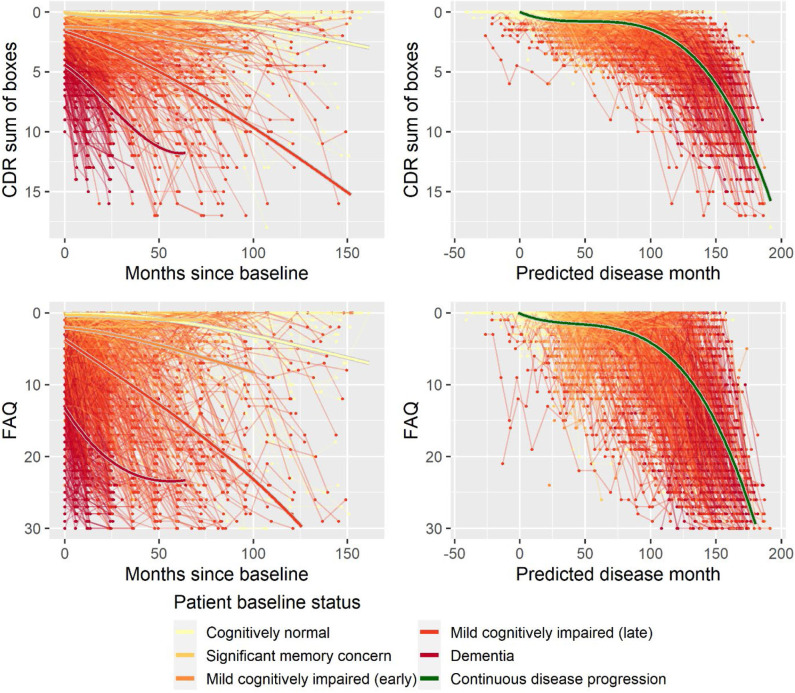
Data and estimated biomarker trajectories for CDR sum of boxes and FAQ. Left column shows results when allowing different trajectories for the five baseline groups; right column shows the results when requiring a single trajectory over predicted disease time.